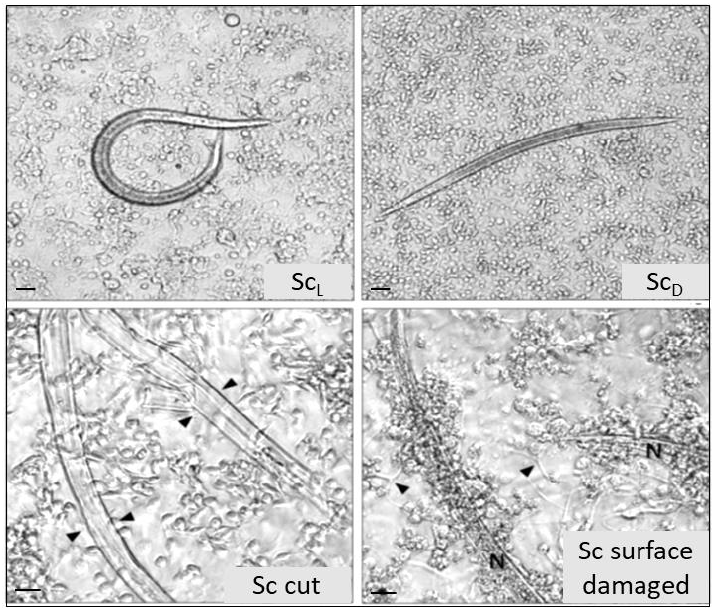
Figure 19. Evasion from encapsulation, of live (Sc L ) or dead (Sc D ) S. carpocapsae and their isolated cuticles (Sc cut). Chemical damage of the parasite body surface results in the loss of its elusive properties (Sc surface damaged). Bars = 100 µ m (from [169]).